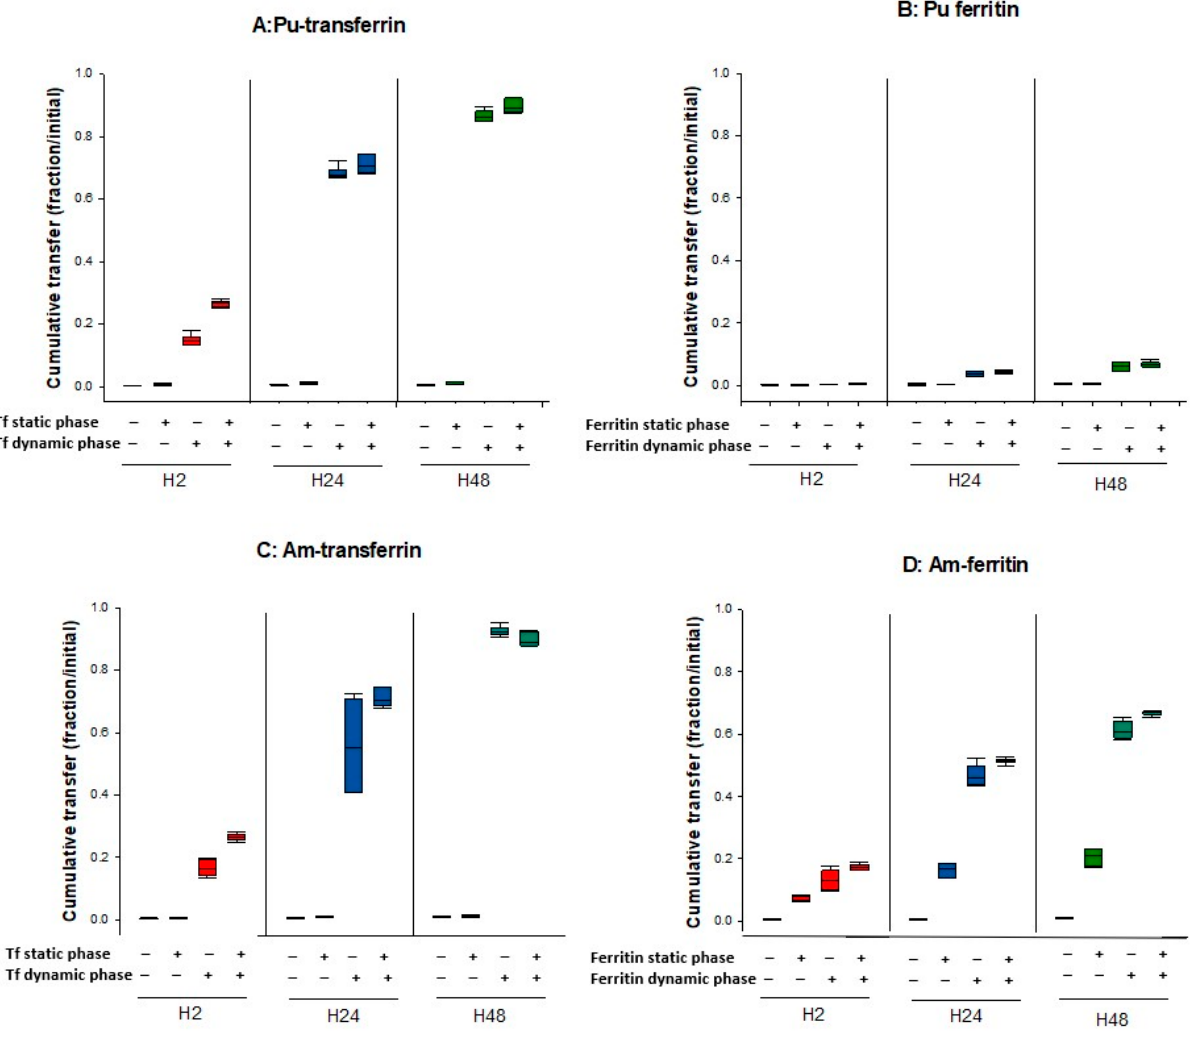
Figure 5. Transfer of Pu/Am in the presence or not of ligands in the static or dynamic phase. Pu ( A , B ) or Am ( C , D ) were resuspended in water or in ApoTf or ferritin and included in the static retention phase (agarose gels) prepared in DPBS. ApoTf 50 µ M or ferritin 10 µ M were added in the dynamic phase or not. The – and + signs indicate the absence or the presence of protein in a specific phase. After 2, 24, and 48 h incubation in DPBS, the transferred activity was measured in the dynamic phase using liquid scintillation counting. Results are expressed as cumulative activity/initial activity in the gel. Each experimental condition was done in triplicate and repeated